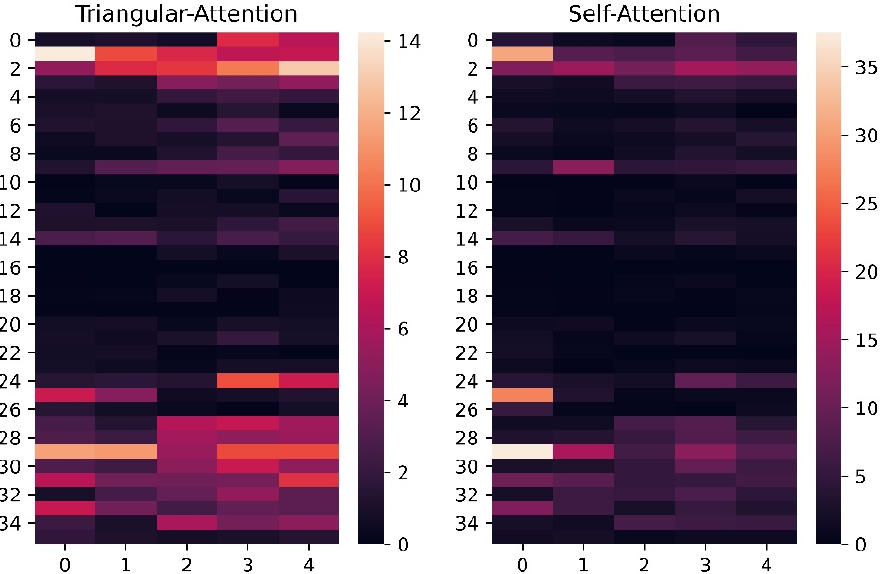
Figure 11. Visualization of weighting score calculated by the triangular attention and the self-attention. The three samples numbered 0 to 2 represent the Vundo software in Dataset B, and the two samples numbered 3 and 4 represent the Vundo software in Dataset A.